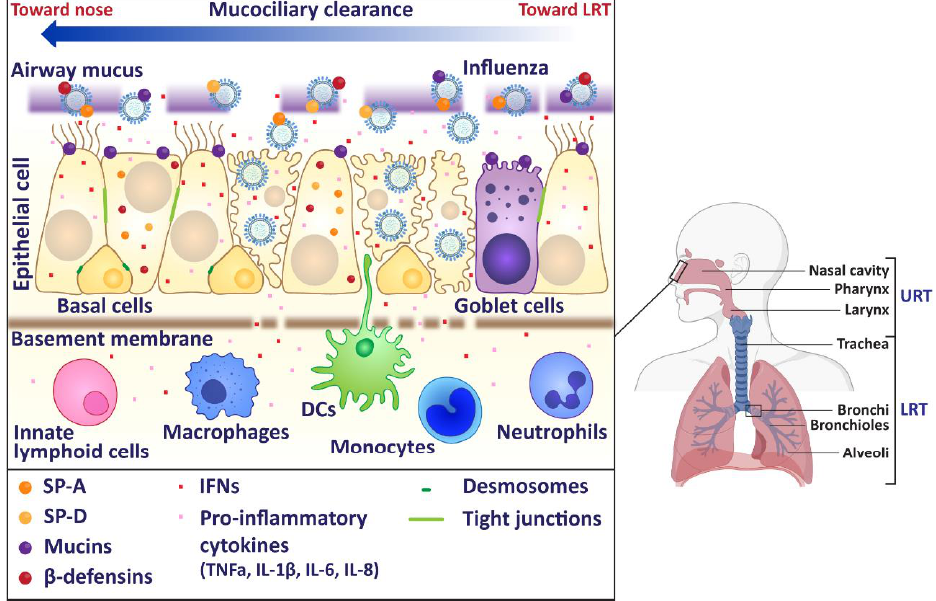
Figure 1. Schematic of human upper respiratory tract. In humans, the upper respiratory tract (URT) consists of the nose, sinuses, pharynx, and larynx. The lower respiratory tract (LRT) includes as the trachea and lungs. Influenza virus infection primarily occurs in the URT, where the virus must first overcome the mucus layer to infect underlying epithelial cells. Influenza virus infections generally cause a self-limiting infection in the URT, but the virus does have the ability to repli- cate in the trachea and the lungs. Image made using BioRender.